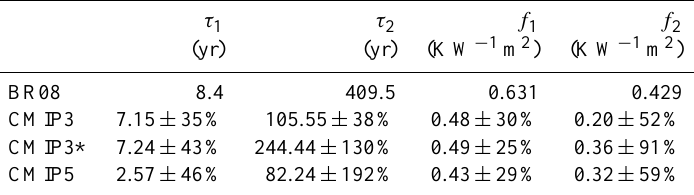
Table 4. Estimates of the parameters in IRF T : BR08 is the IRF T used in Boucher and Reddy (2008), and CMIP3, CMIP3*, and CMIP5 are the IRF T derived using CMIP3 and CMIP5 data. The CMIP3 IRF T is based on AOGCM experiments alone, while the CMIP3* IRF T additionally includes the independently estimated climate sensitivities. The median, and 5- and 95-percentile values are indicated. τ